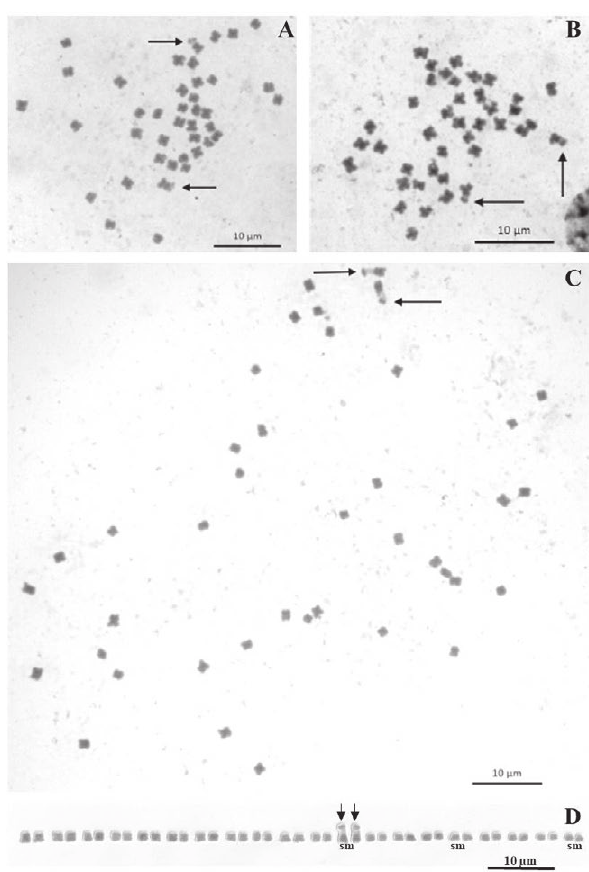
Figure 1. Mitotic metaphase cells of hybrid Aeschynomene 2 n = 4 x = 40. A-C , Metaphase chromosome plates in optimal spread; D, Karyotype 34m + 6sm. The chromosomes are aligned in decreas- ing order. Arrows point to secondary constrictions and satellites on short arms of submetacentric chromosomes.